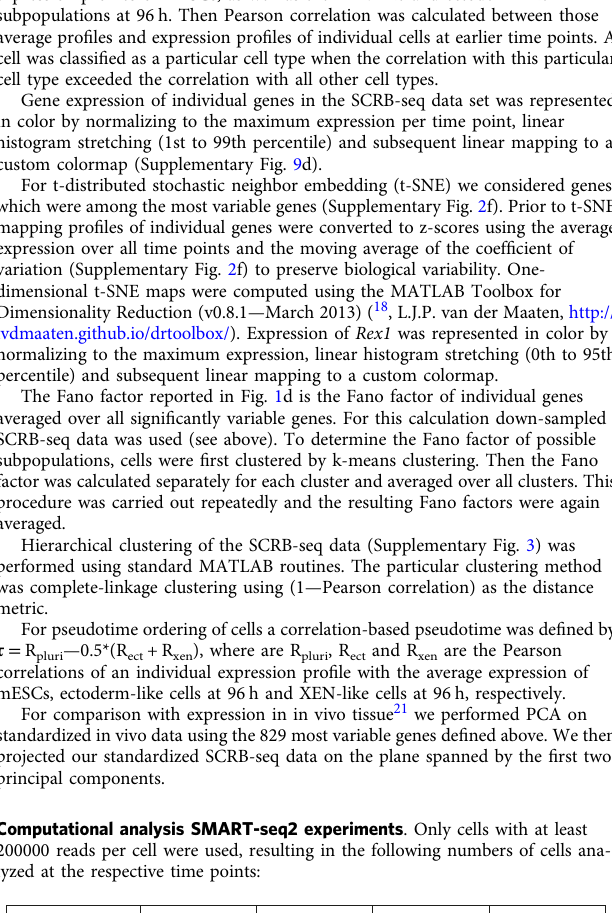
ρ = 0.75). We compared 100 randomly selected pairs of cells growing in 2i/L and found that SCRB-seq measurements of individual cells were strongly correlated (Supplementary Fig. 2h, Pearson correlation ρ = 0.63). By analysis of UMI counts of ERCC spike-in RNA we determined that UMI counts scaled approximately linearly with the spiked-in transcripts — the slope of a linear fi t to the log-log plot of spike ins vs. UMI counts was 0.78. The ef fi ciency of transcript recovery as determined from the offset of that linear fi t was about 0.9% (Supplementary Fig. 2i). For principal component analysis (PCA) we considered genes, which belonged to the upregulated clusters (clusters 5 and 6, Supplementary Fig. 1a) and were among the most variable genes (Supplementary Fig. 2f). Prior to PCA expression pro fi les of individual genes were converted to z-scores using the average expression over all time points and the moving average of the coef fi cient of variation (Supplementary Fig. 2f) to preserve biological variability. PCA was performed with all cells across all time points and expression pro fi les of individual cells were then projected on the principal components thusly determined. The genes with the highest loadings in the fi rst two principal components are listed in Supplementary Fig. 3a and their loadings are represented graphically in Supplementary Fig. 3b. To discover clusters of cells we used k-means clustering including all 829 most variable genes with (1 — Pearson correlation) as the distance metric. Cluster-wise